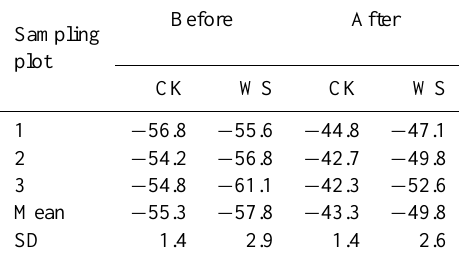
Table 3. Dry matter accumulation of rice plants aboveground and underground; mean ± SD, n = 3. WS: straw incorporation, CK: without straw